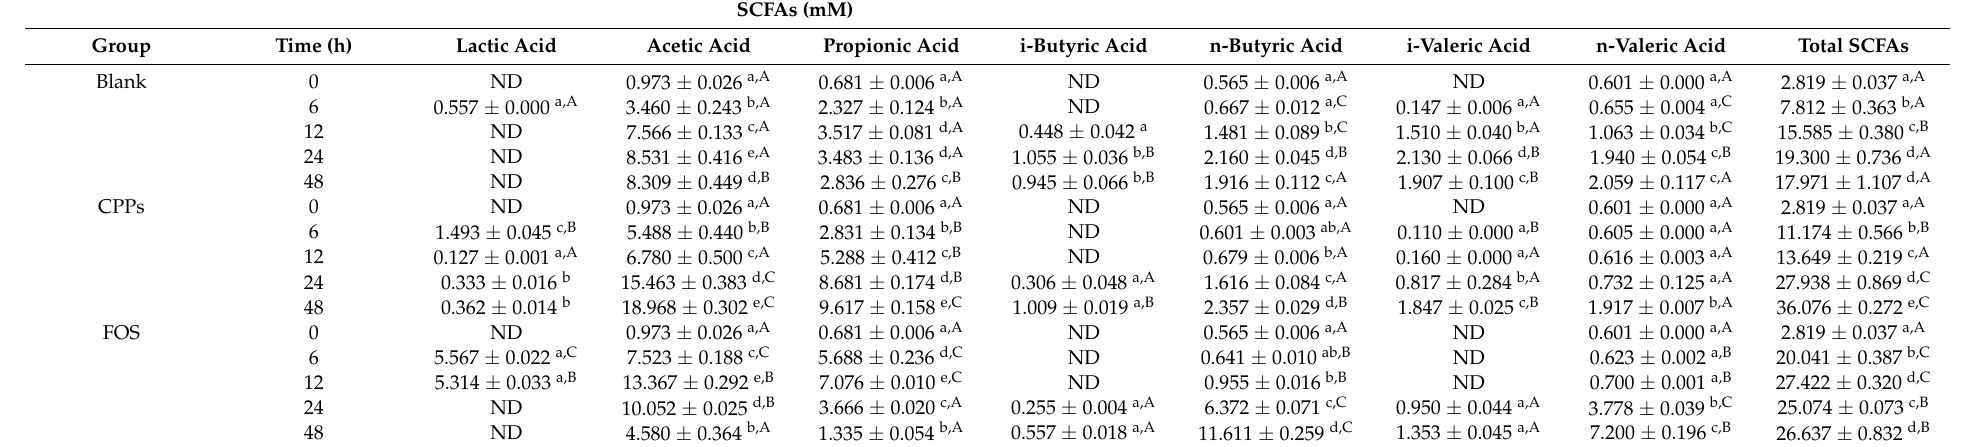
Table 3. Concentrations of individual and total SCFAs at different time points of